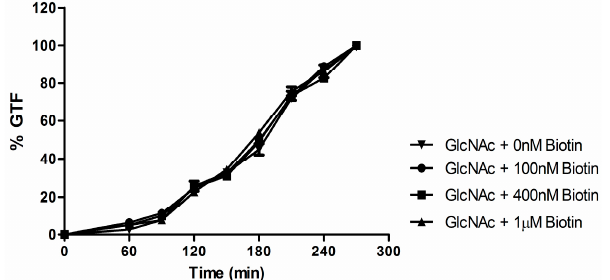
Figure 6. Germ tube formation at 2.5 mM N-acetylglucosamine (GlcNAc) is not affected by the addition of biotin. Three times washed inocula were incubated at 37 °C with rotary agitation at 220 rpm. Cultures were observed for 5 h, and plotted as: ▼ , no addition; , 100 nM biotin; , 400 nM biotin; and , 1 µM biotin. Values shown are the average of triplicate experiments + SD. Virtually